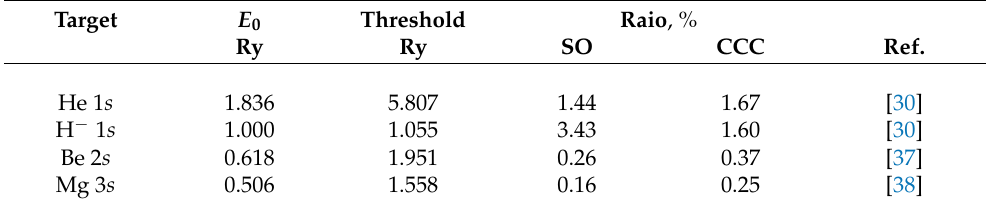
Table 1. Asymtptoc double-to-single cross-section ratios in various targets as calculated by the SO model using Equation (5) and compared with earlier CCC calculations.